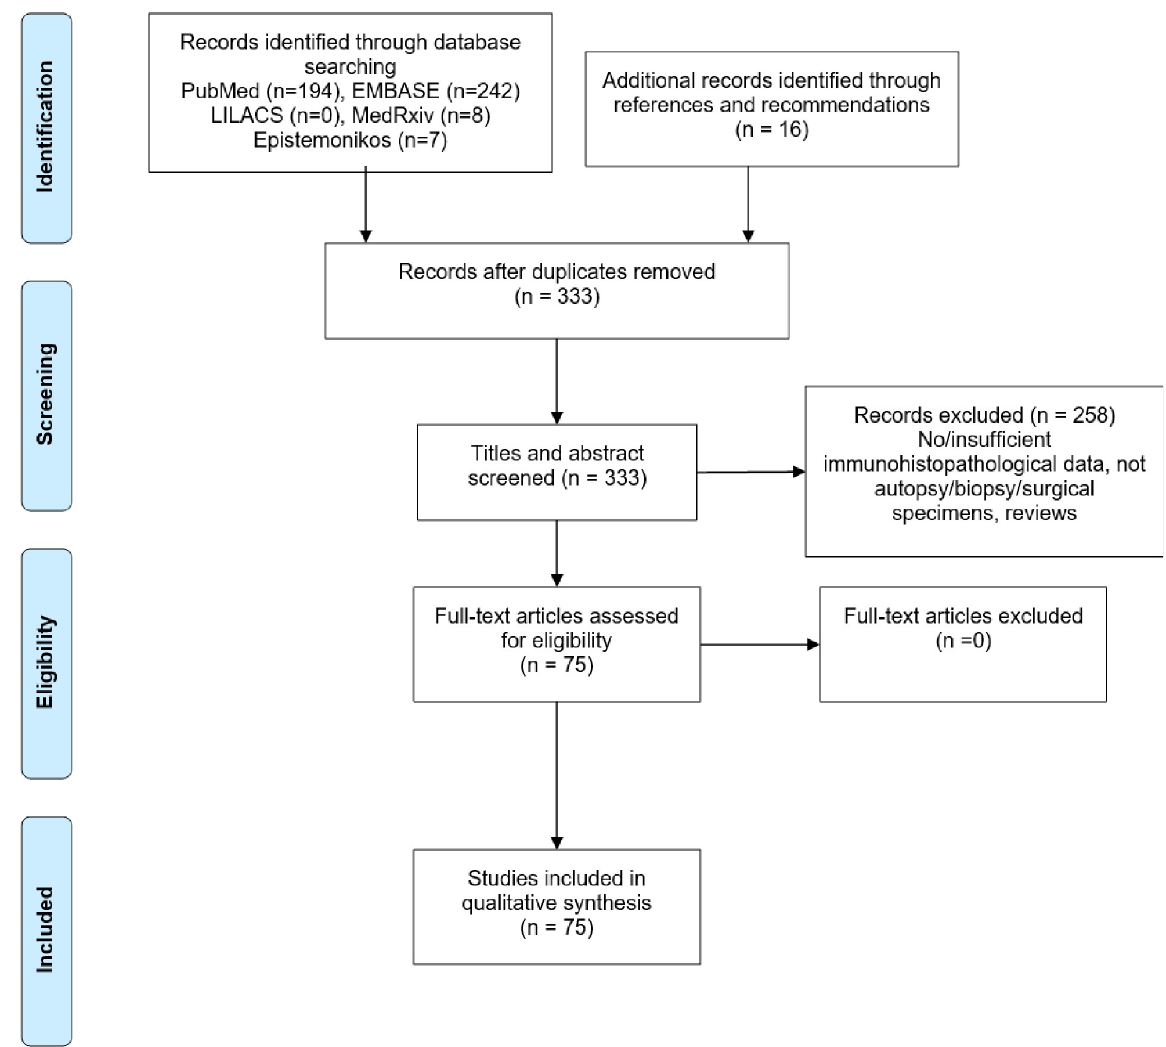
Fig 1. PRISMA flow diagram of literature search and selection